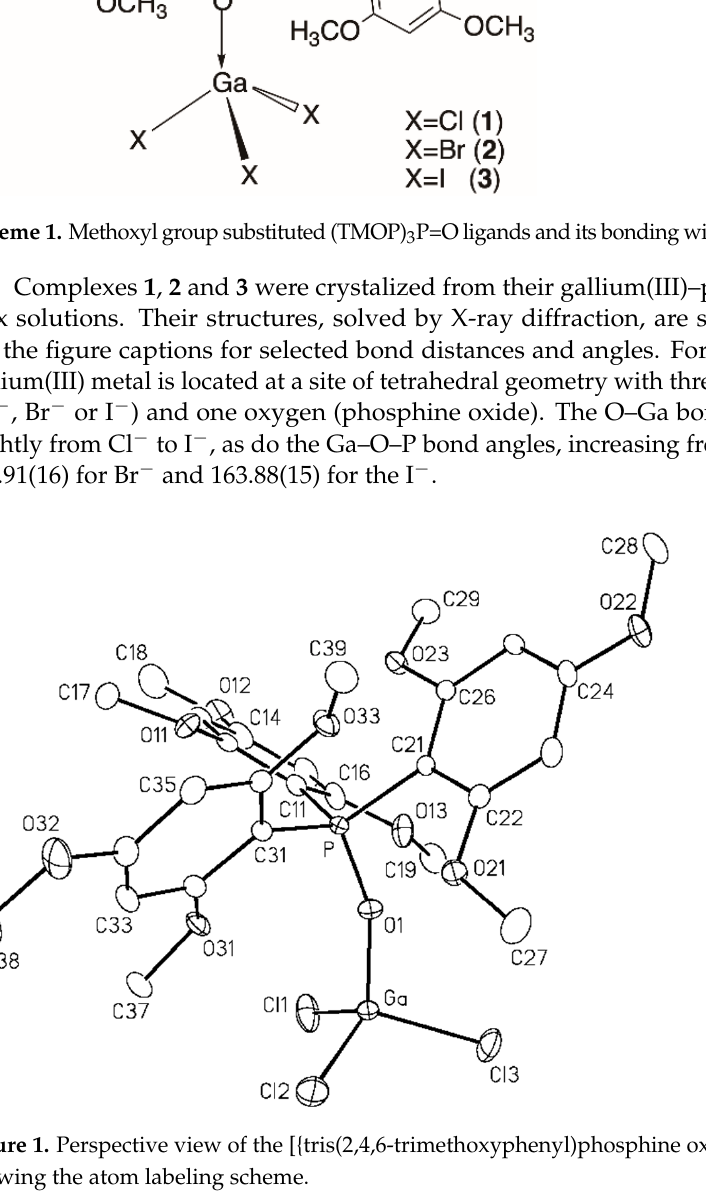
Figure 1. Perspective view of the [{tris(2,4,6-trimethoxyphenyl)phosphine oxide}GaCl 3 ] (1) mole-